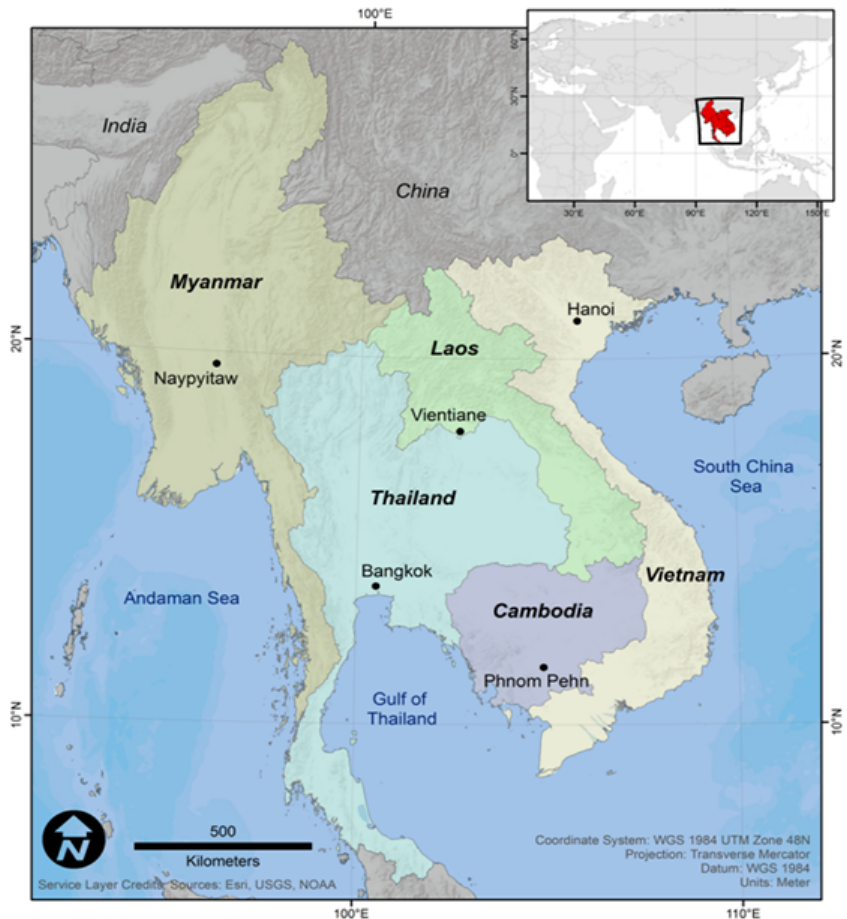
Figure 1. The Mekong study area includes Cambodia, Lao People’s Democratic Republic, Myanmar, Thailand, and Viet